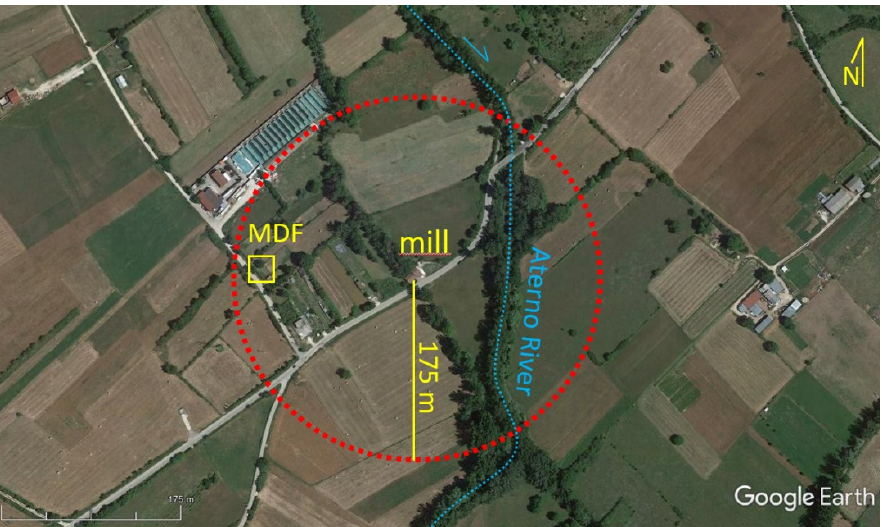
Figure 3. Map identifying the red circle with the radius of 175 m where the two sinkholes occurred during the 1703 earthquake are likely located. The ancient mill and the Aterno River are also high- lighted. Within this area, the selected MDF site is located. In the most restrictive hypothesis, if a sinkhole had formed near the mill, the other must have been at least 175 m away. Therefore, the selected site for the investigations was chosen (i) within the area of a circle with a radius of 175 m; (ii) distant from the current riverbed of the Aterno River to avoid carrying out investigations in post- 1703 alluvial deposits because close to the current riverbed, and (iii) for logistical reasons (accessi- bility for the borehole machinery, etc.).